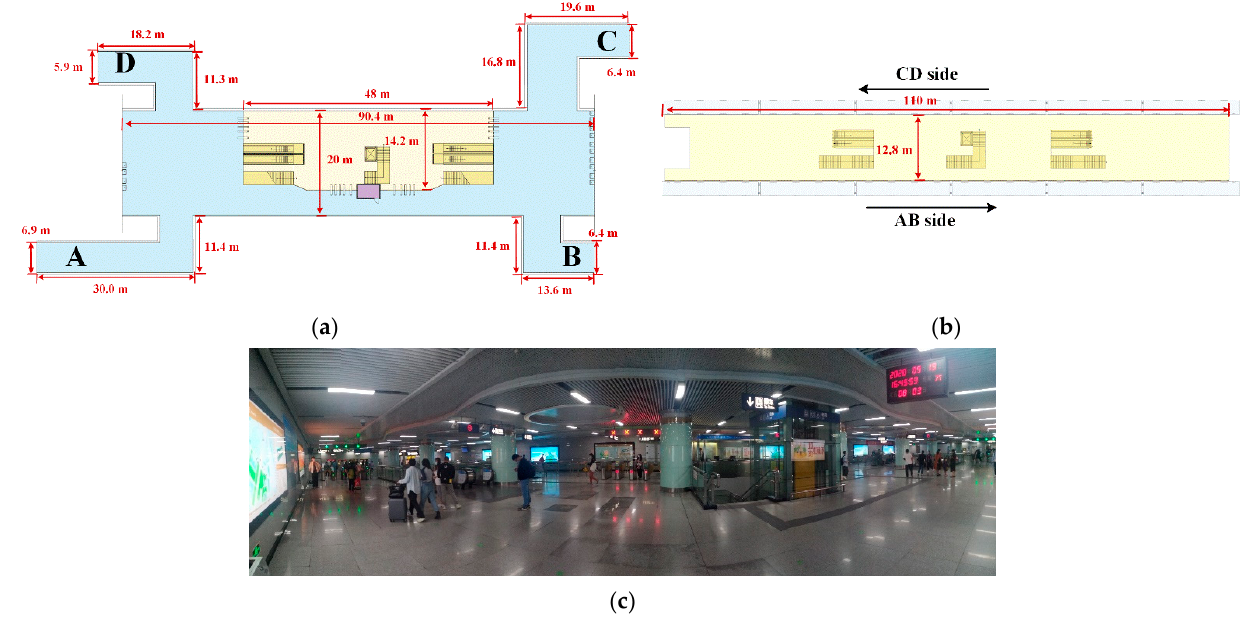
Figure 2. The floor plan of the concourse floor and platform floor: ( a ) The concourse floor; ( b ) The platform floor; ( c ) A view of the concourse floor.